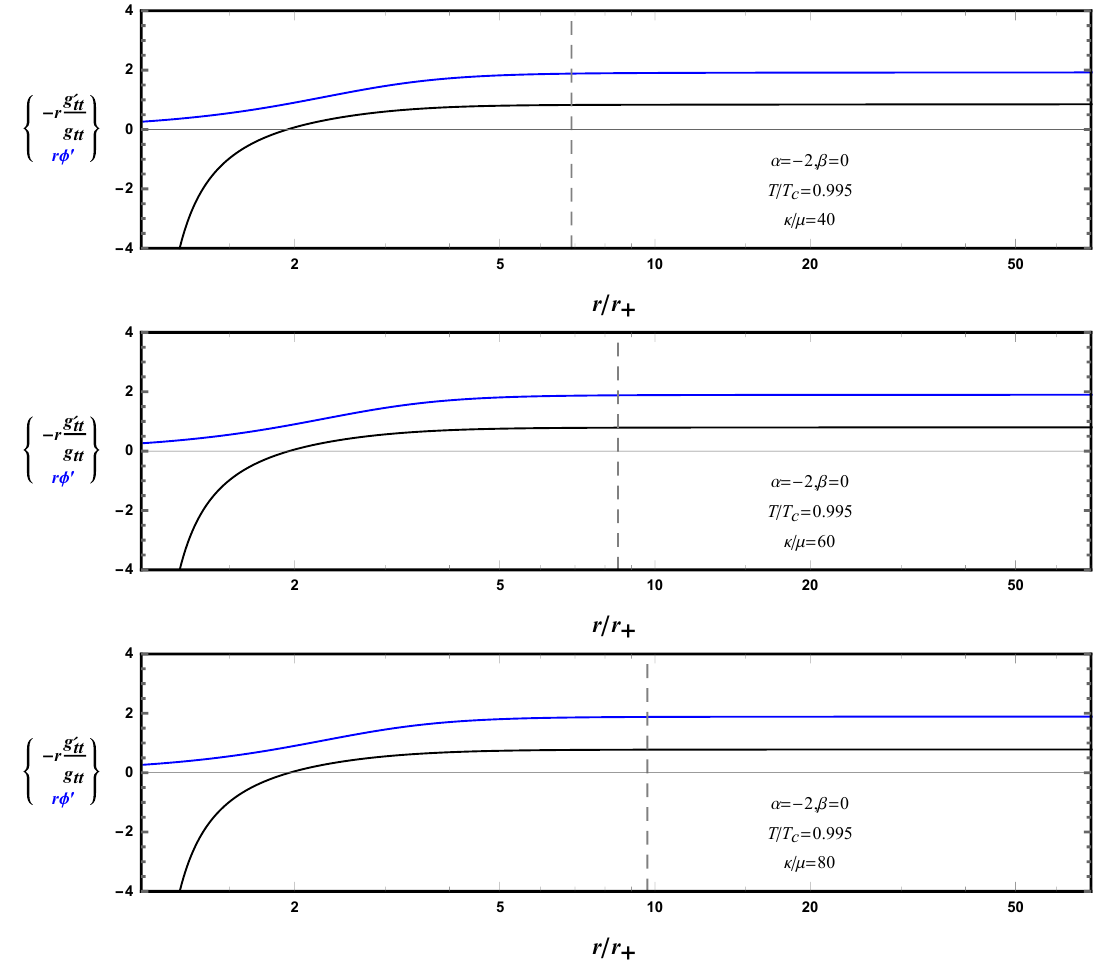
Figure 19 . An example of an interior evolution with no ER bridge collapse and Josephson oscil- lations epochs in the pure non-linear massive configuration. Clearly, the system enters the Kas- ner geometry immediately after the would-be inner horizon. Numerics are at T/T c = 0 . 995 and κ/µ = 40 , 60 , 80 from top to